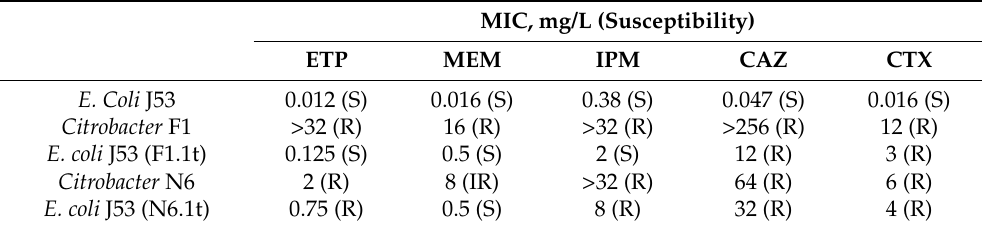
Table 2. MICs of carbapenems and cephalosporins for Citrobacter isolates F1 and N6, transconjugants E. coli J53::KPC, and recipient strain E. coli